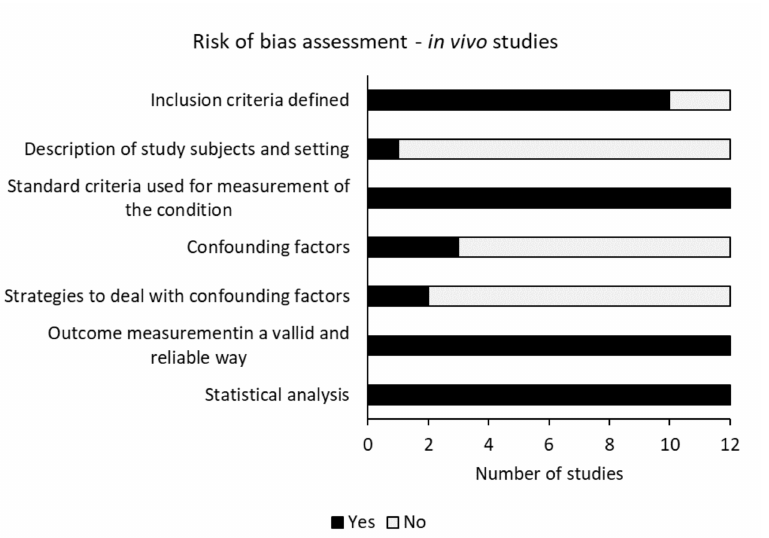
Figure 3. Risk of bias assessment of all included in vivo studies. Risk of bias was evaluated by assessing specific criteria, which was adapted from the Joanna Briggs Institute Critical Appraisal Checklist for analytical cross-sectional